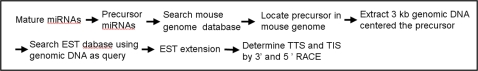
Schematic representation of the database mining for miRNA primary transcripts.MiRNA precursor sequences were used as a query to search the mouse genome database. After locating the miRNA precursor in the genome, a 3 kb sequence centered miRNA precursor was extracted and used as a query to search EST and non-coding RNA databases. After filtering the Blast hits, the EST surrounding the miR-precursor was used as template to design RACE primers to identify the transcriptional initiation site (TIS) and transcriptional termination site (TTS).